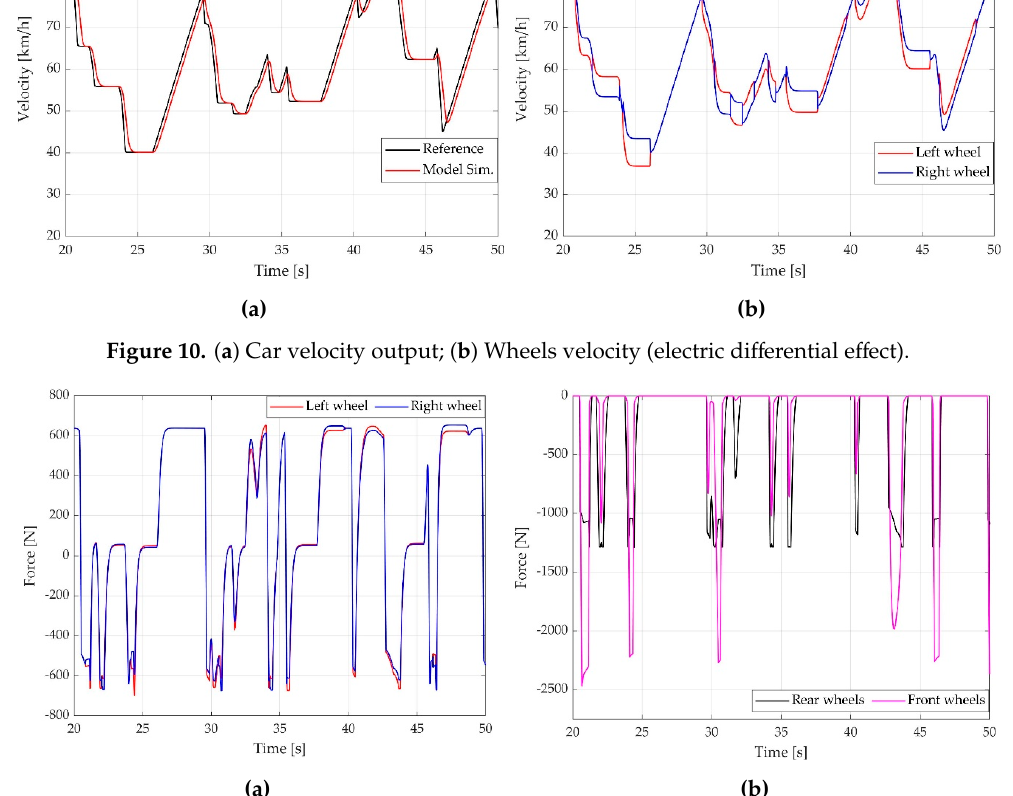
(b) Figure 13. State of charge and battery current, (a) full racetrack; (b) zoom in t=14-17 s. 5.3. Comparison of Different Braking Strategies The proposed strategy is compared to three different braking strategies. Two fixed braking distribution strategies are found in [36], with distribution variables 𝑘 (cid:3080) = 0.75 and 𝑘 (cid:3080) = 0.55 . A third variable that considers the ideal braking distribution curve summarized in Section 4.1 is used to compare the results. Now, energy recovery and car stability are studied to highlight the importance of the braking strategy. Figure 14 shows the energy consumed by the car studied during an endurance test of the Formula SAE, which has 22 km length. The car performance is studied without RBS as a reference to compare the energy recovery potential of the different braking strategies. Assuming constant road conditions and an adhesive coefficient of 0.9, the braking strategy proposed has the lowest energy consumption. Of the other three, the strategy that uses the ideal